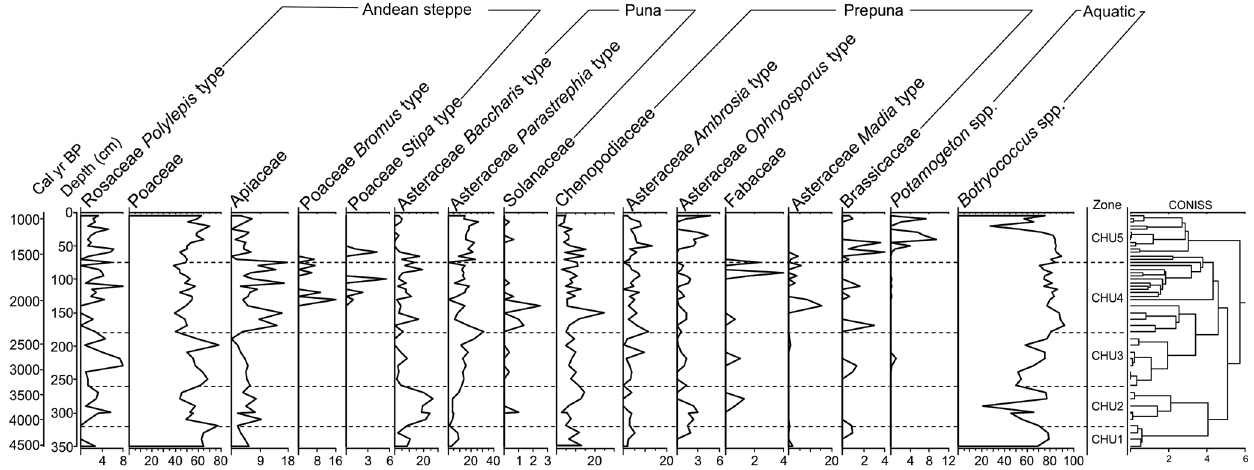
Figure 4. Terrestrial and aquatic pollen percentages from core 7 in Lago Chungará. Pollen percentages are plotted against depth and age scales (Giralt et al., 2008). The diagram also shows the main zones of the records (right) determined with the aid of a CONISS cluster